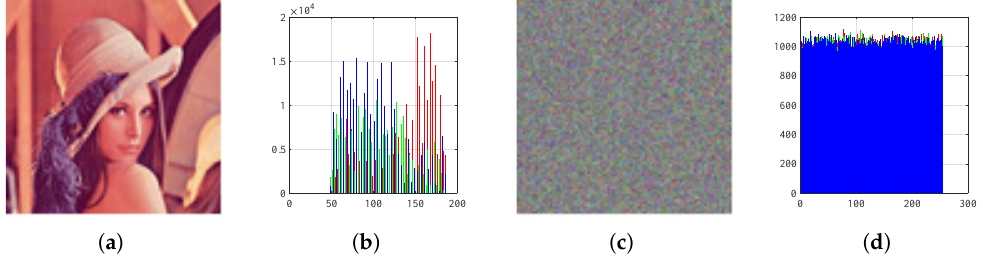
Figure 14. Histograms: ( a ) Lena image, ( b ) histogram of plain Lena, ( c ) encrypted Lena, and ( d ) histogram of encrypted